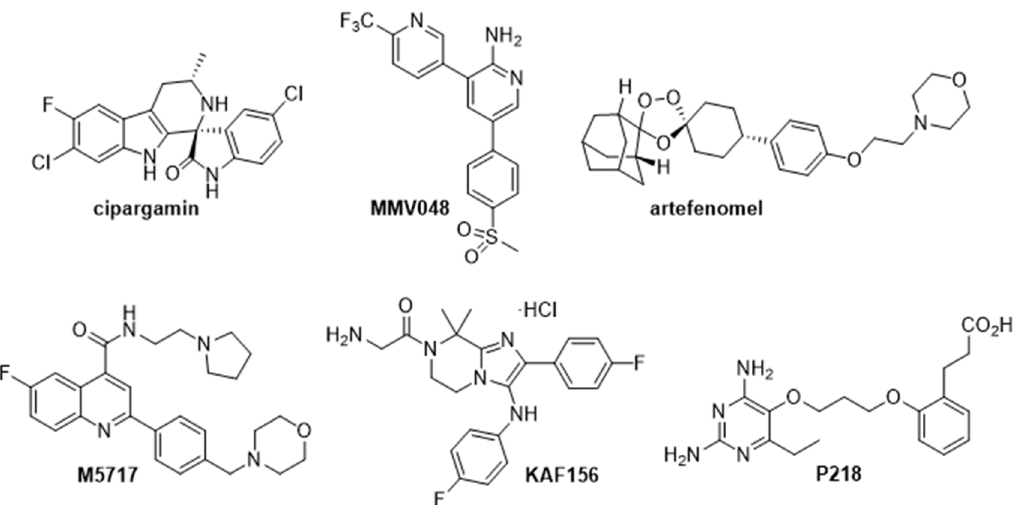
Figure 3. Chemical structures of the most advanced compounds in the current global antimalarial portfolio.